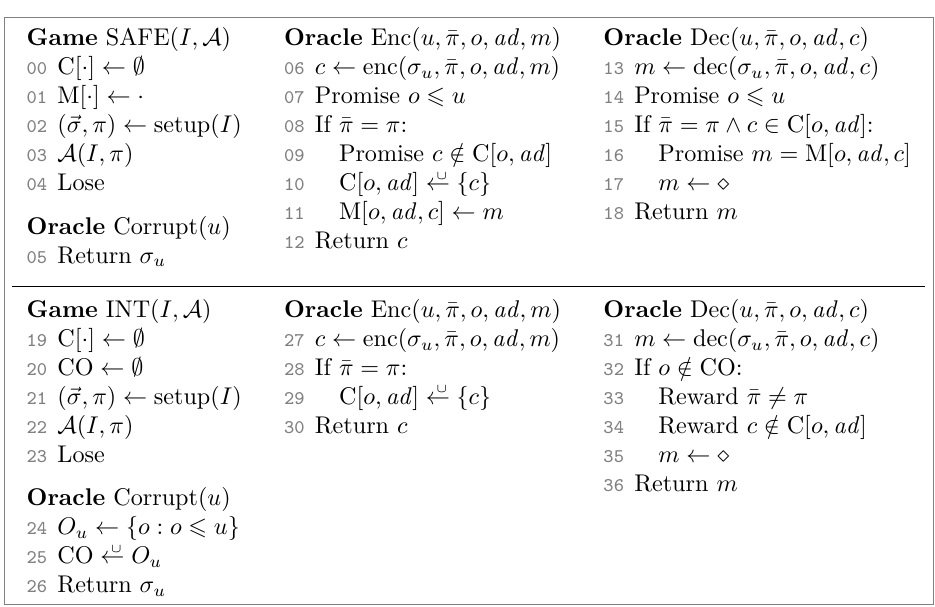
Figure 6: SAFE and INT games for RWES (the IND b games are in Fig. 7). For all